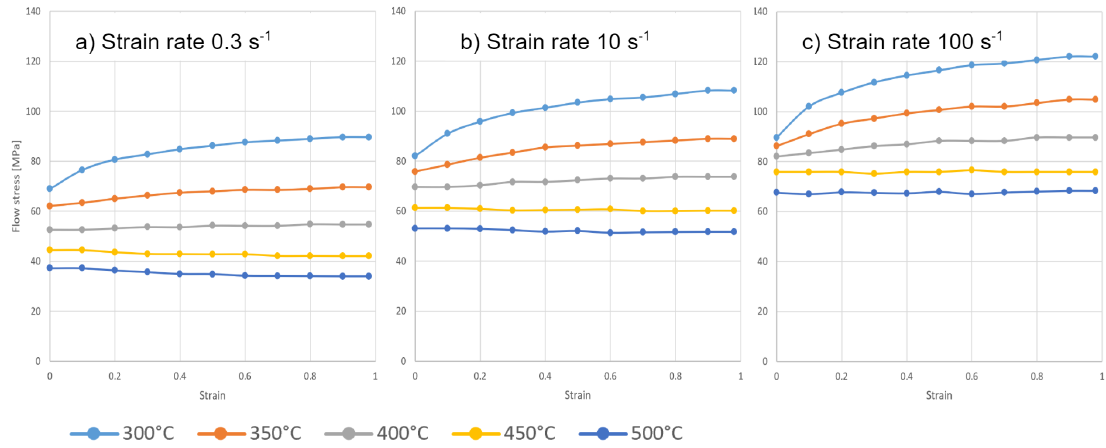
Figure 3. Material data for AA6082 at in the range 300 ◦ C to 500 ◦ C for strain rates: ( a ) 0.3 s − 1 , ( b ) 0.3 s − 1 and ( c ) 100 s − 1 . Data is obtained from Deform 3D material library based on [21].